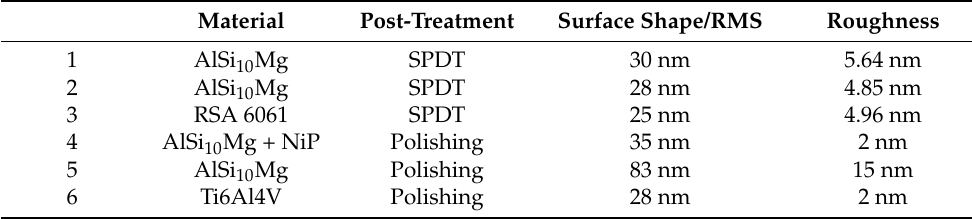
Figure 25. Schematic diagram of several experimental methods [65].